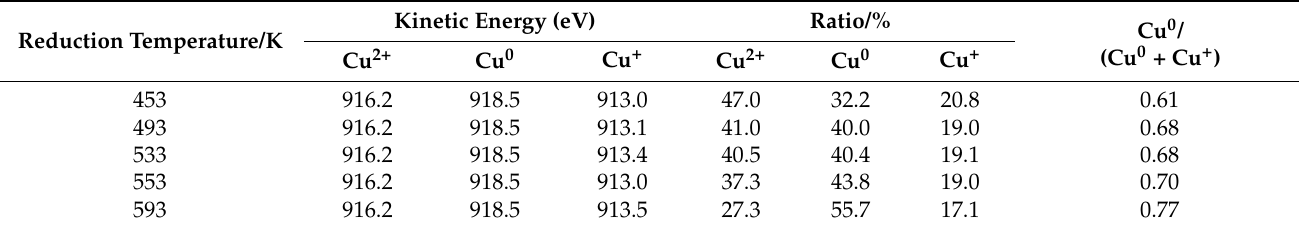
Table 4. Cu LMM results of CMA-L catalysts after